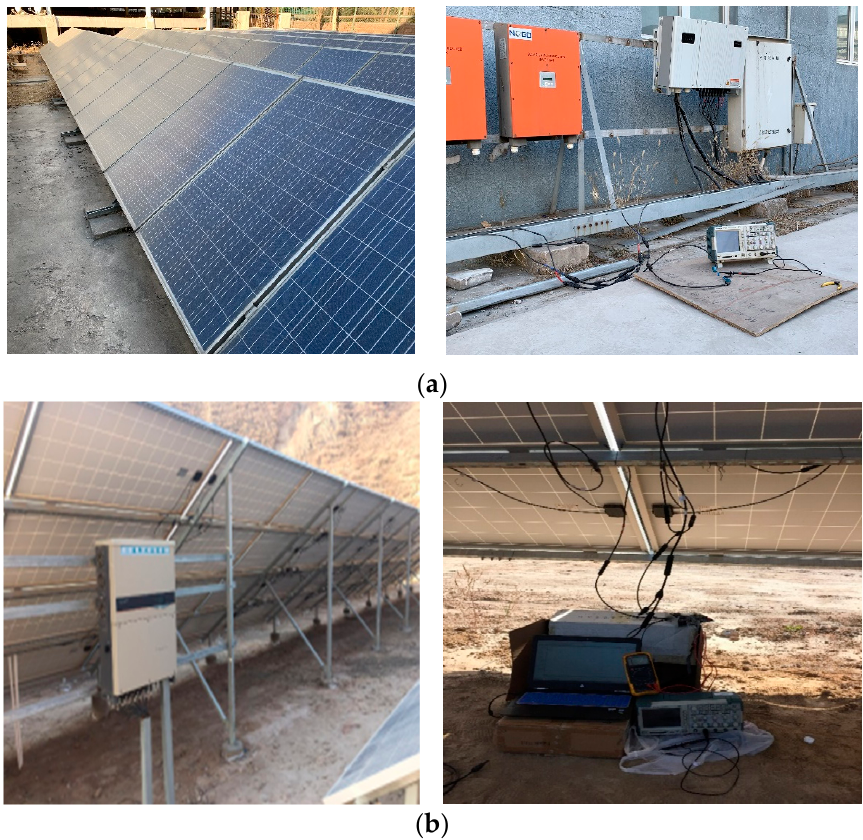
Figure 1. Photovoltaic series channel noise measurement environment. ( a ) Experimental platform 1 noise measurement environment; ( b ) Experimental platform 2 noise measurement environment.